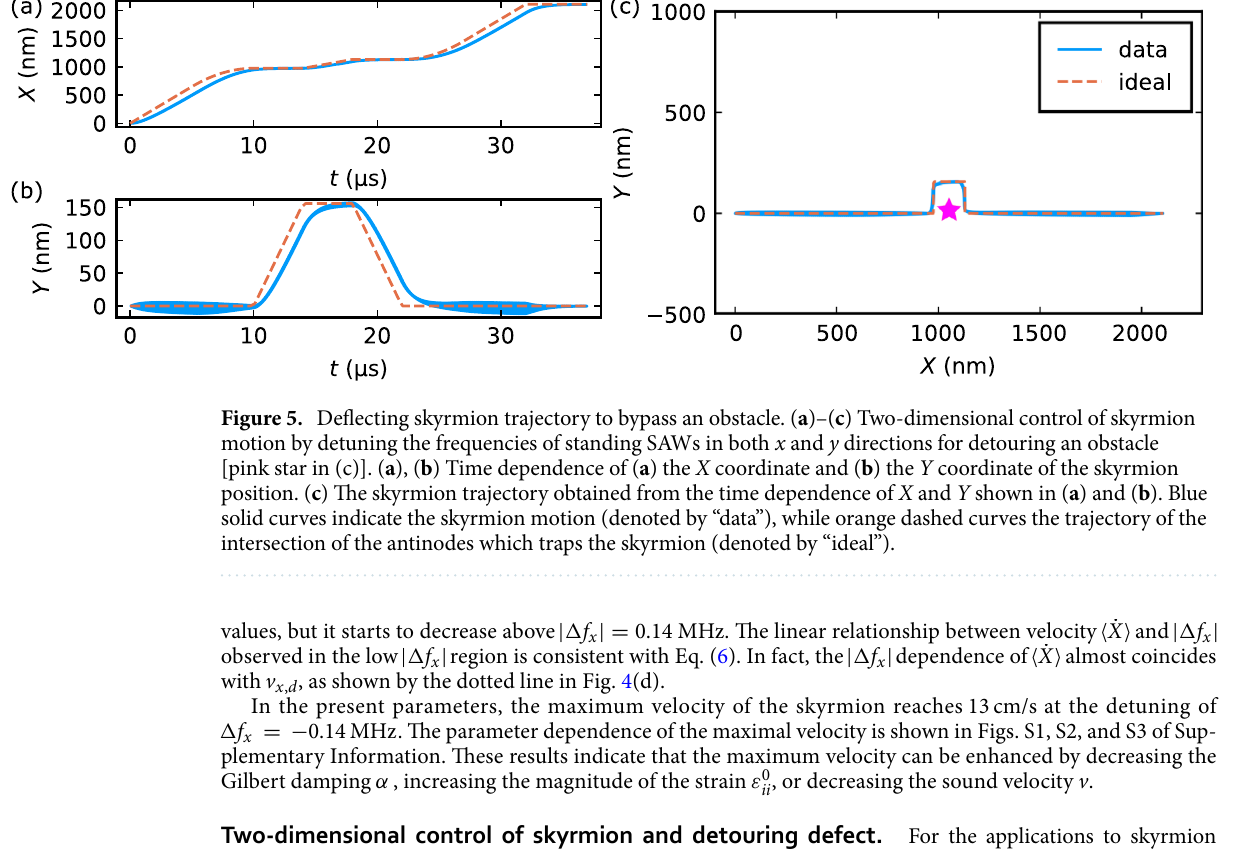
(cid:31) f x region is consistent with Eq. (6). In fact, the | |